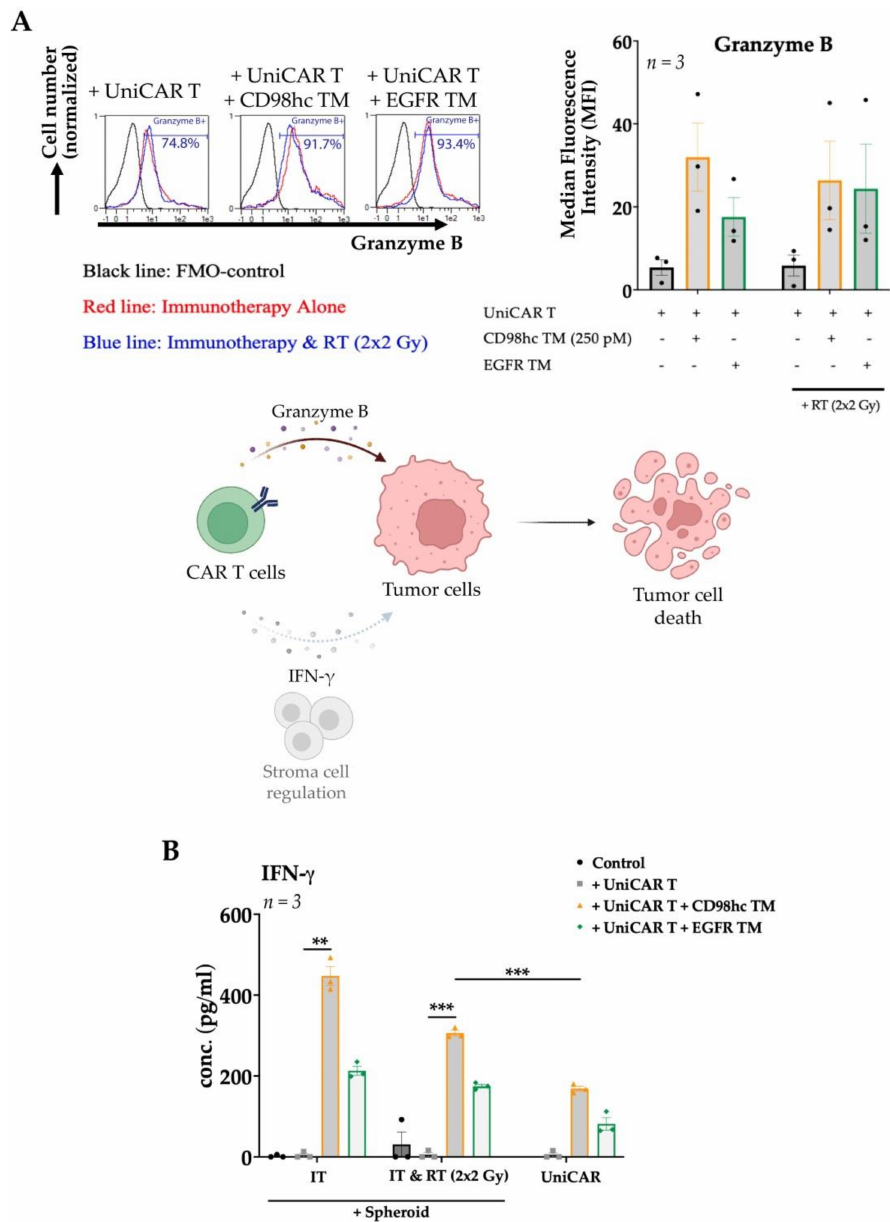
Figure 6. Granzyme B and IFN- γ production of CD98hc-redirected UniCAR T cells. UniCAR T cells were cocultured with Cal33 RR spheroids at an E:T ratio of 5:1 together with CD98hc TM at a concentration of 250 pM. ( A ) After 48 h, UniCAR T cells were analyzed by flow cytometry for intracellular granzyme B expression. Histograms show the UniCAR T cells positive for granzyme B, % (left panel): fluorescence minus one (FMO) control (black line), immunotherapy (red line), RT combined with immunotherapy (blue line). The bar graph shows the median fluorescence intensity (MFI) of granzyme B stained UniCAR T cells (right panel). CAR T cell utilize granzyme B production and can regulate stromal cells via IFN- γ secretion to mediate tumor cell elimination (lower panel). Created with https://biorender.com, accessed on 24 January 2022. ( B ) IFN- γ production profile of UniCAR T cells incubated with or without Cal33 RR spheroids in the presence or absence of 250 pM CD98hc TM (E:T = 5:1). After 48 h, cell-free supernatants were analyzed by ELISA for IFN- γ . IT: Immunotherapy; RT: Radiotherapy; IFN- γ : Interferon-gamma Experiments were performed in triplicates. One-way ANOVA with post hoc Tukey multiple comparison test was applied to calculate the statistical significance (treated vs. control spheroids); error bars, mean ± SEM. ** p < 0.01, *** p <